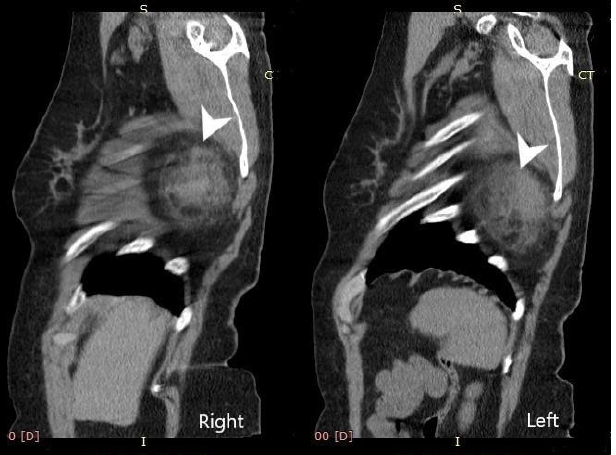
. . Figure 3. Bilateral sagittal view—elastofibroma dorsi (tumors are indicated by the white arrows). Figure 3. Bilateral sagittal view—elastofibroma dorsi (tumors are indicated by the white arrows). Figure 3. Bilateral sagittal view—elastofibroma dorsi (tumors are indicated by the white Figure 3. Bilateral sagittal view—elastofibroma dorsi (tumors are indicated by the white arrows).